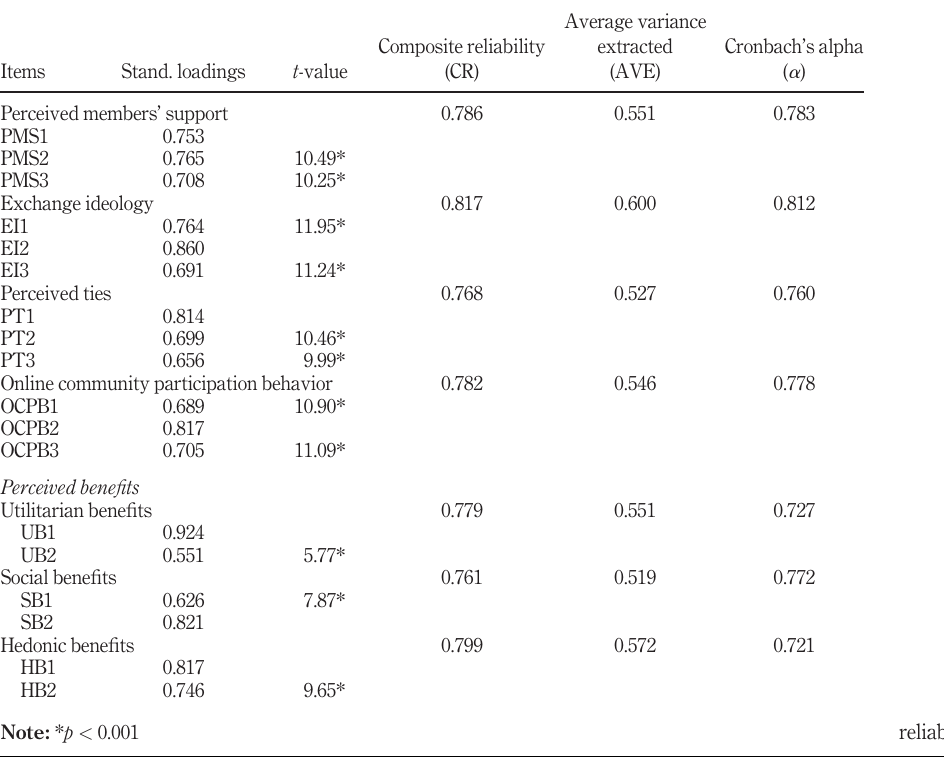
Table 2. Standardized estimates and reliability